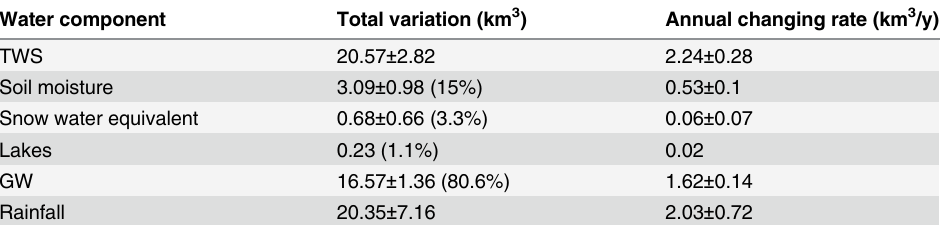
Table 2. Variations of water components of TWS and precipitation around the QB between 2003 and 2012. The brackets in the second column show the percentage contribution for each component of the TWS. Errors are calculated except for the data related to lakes because the lake level from [26] had no error